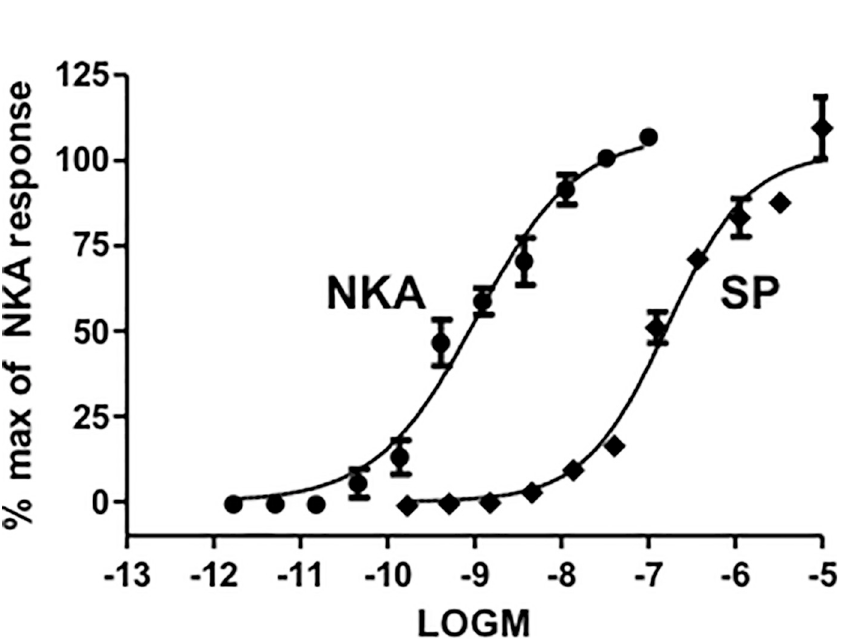
Fig 3. Concentration-response curves for NKA and substance P on intracellular calcium response using human cloned NK2 receptors. Data are expressed as % of maximal response to NKA (30 nM). Each data point is the mean ± SD of data from an individual experiment performed in